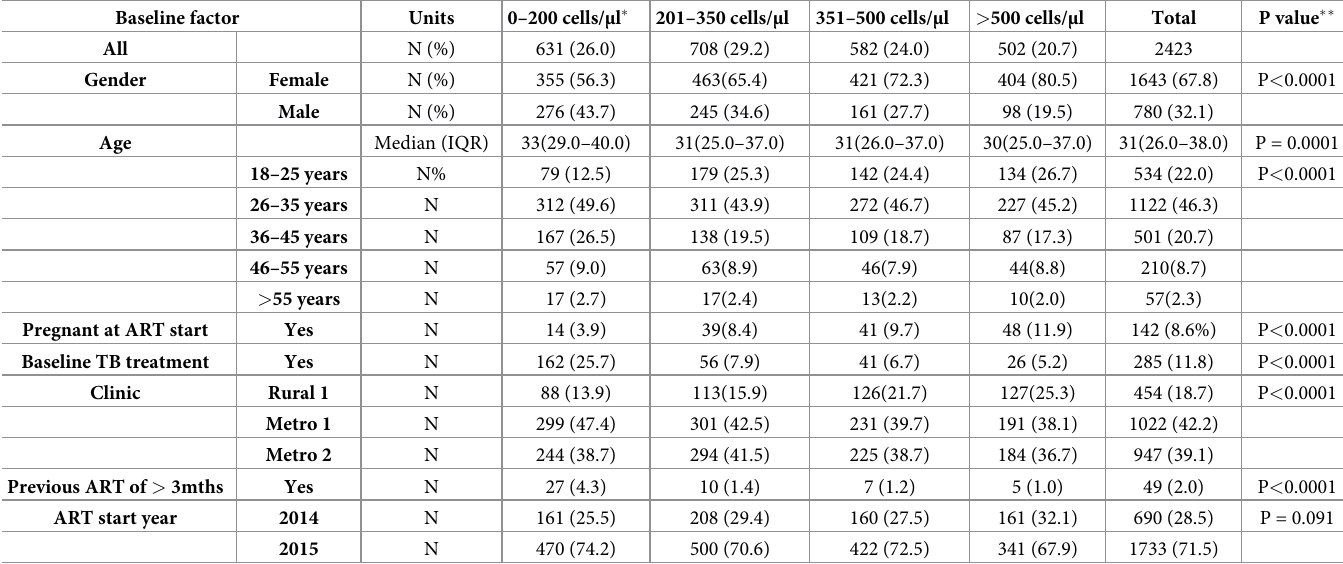
Table 1. Baseline